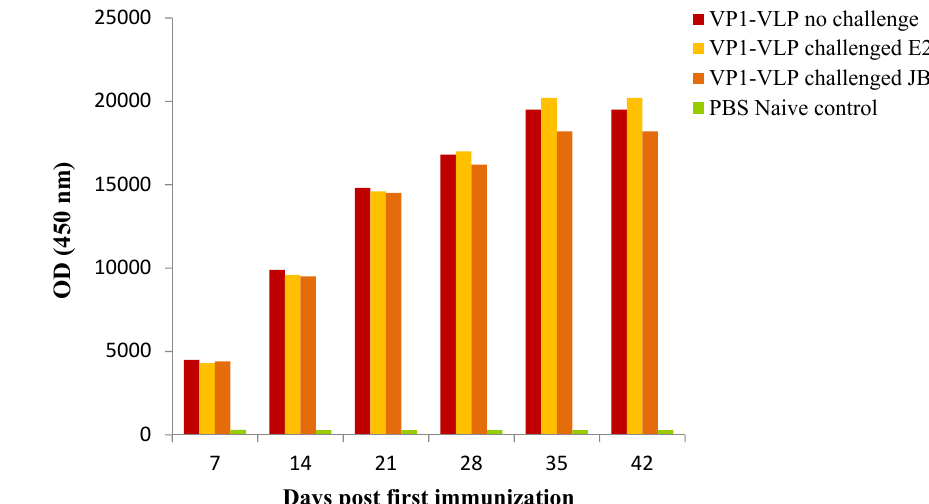
Figure 4. Antibody response. Serum IgG recognizing VP1-VLP in immunized mice. Titers of total IgG in the three immunized groups of mice. Mice ( n = 5) receiving CVB4E2 VP1-VLP vaccine were immunized intraperitoneally by prime-boost regimen at days 0 and 15 with 0.5 µg of VP1-VLP. Mice were then challenged at day 22 with CVB4E2 or CVB4JBV pathogenic strains. PBS naïve mice group represents the control group. The results represent the mean of three replicate experiments.